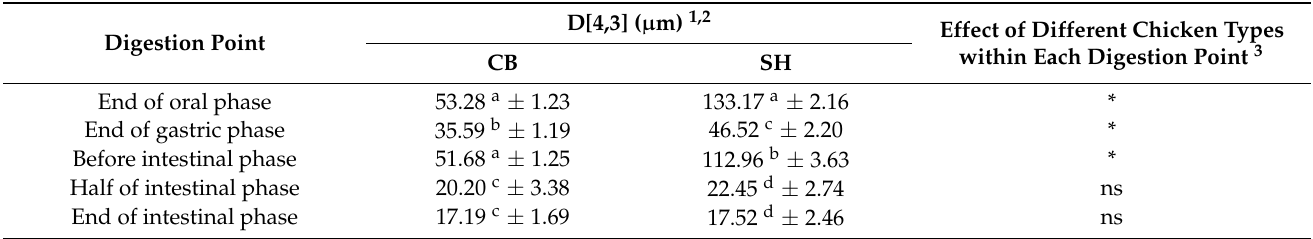
Table 4. Volume weighted mean (D[4,3]) of commercial broiler breasts (CB) and spent commercial laying hen breasts (SH) digested by method 2 and collected at different digestion